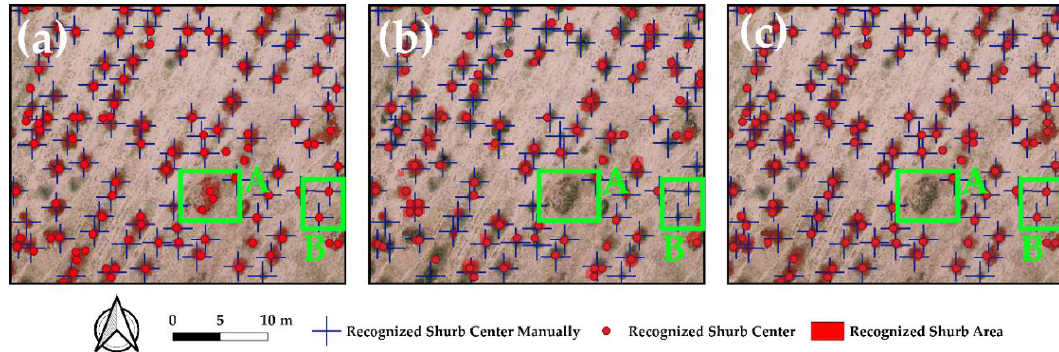
Figure 5. Shrub Identification Results in A Sample Area by: ( a ) OOF; ( b ) DSM-DTM; ( c ) CODA.